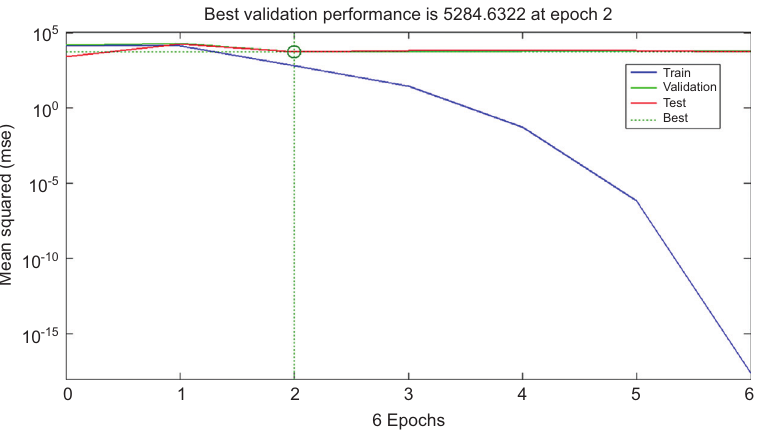
nanofluid for case 2. 2